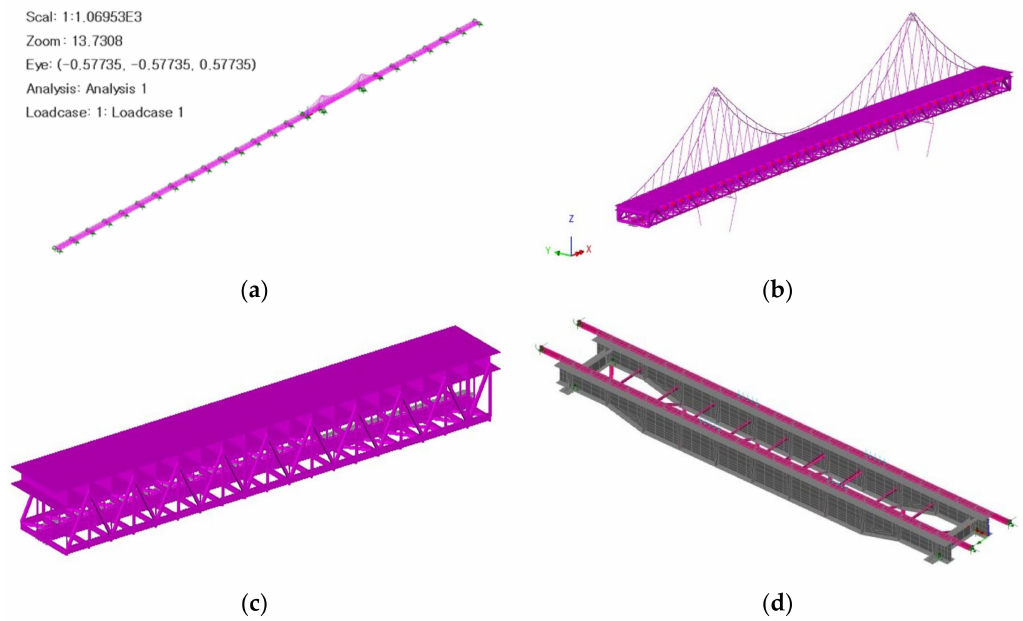
Figure 3. Yeongjong Bridge and track modeling. ( a ) Full model; ( b ) Suspension bridge; ( c ) Truss bridge; ( d ) Yeongjong Bridge track girder